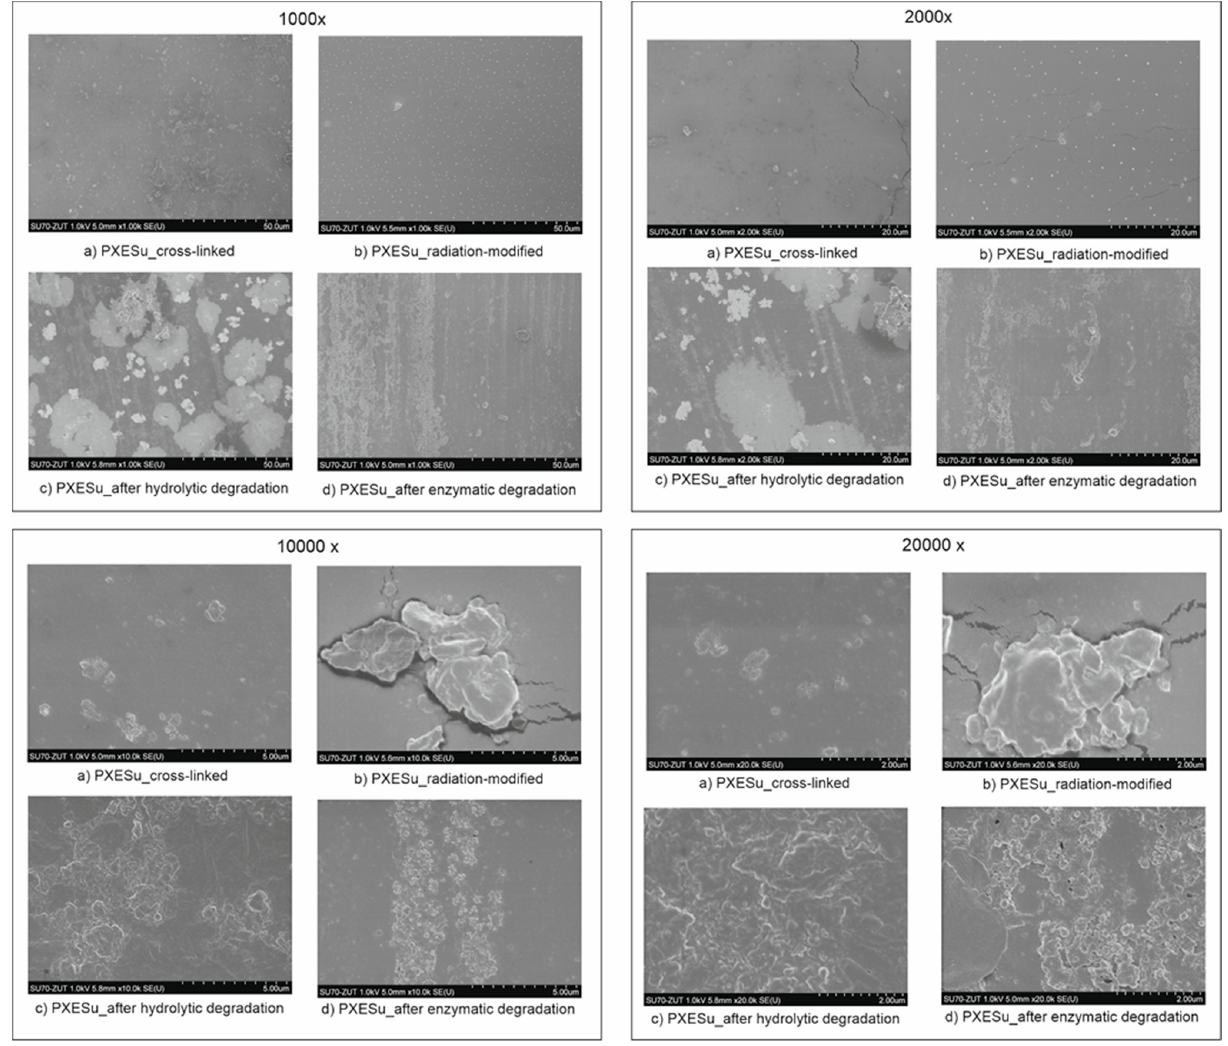
Figure 16. Scanning electron microscopy (SEM) images of PXESu crosslinked ( a ); PXESu radiation-modified ( b ); PXESu after hydrolytic degradation ( c ); PXESu after enzymatic degradation ( d ).